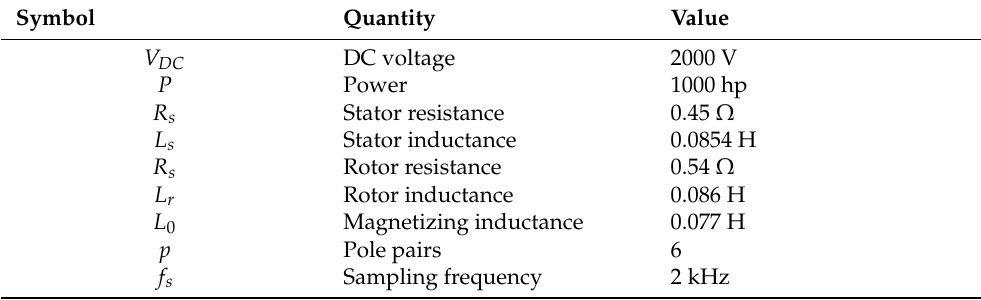
Table 3. Simulation parameters.